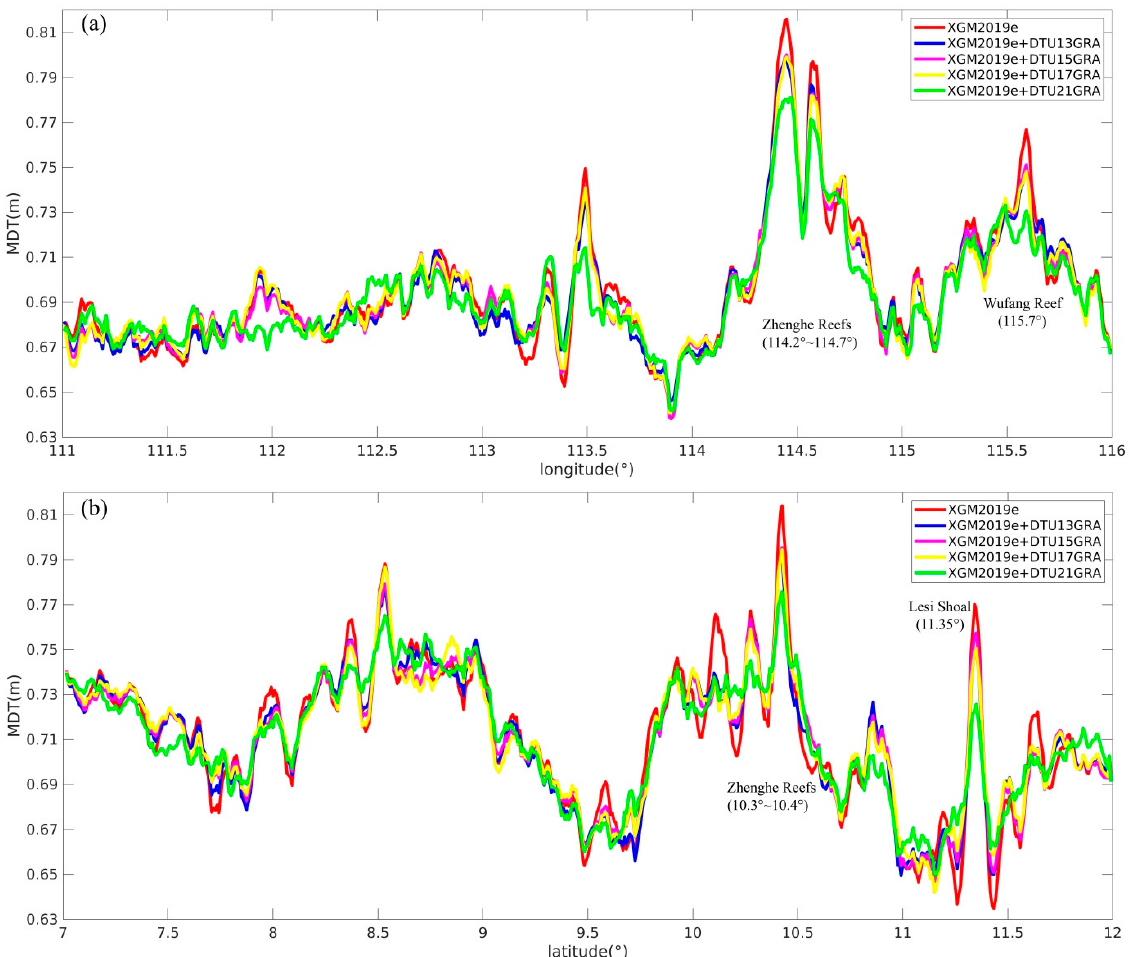
Figure 4. Profiles of various MDTs computed from different gravity field models along latitude 10.4°N ( a ) and longitude 114.6°E ( b ). Note: only DTU21GRA was computed with the SAR altimeter 10.4 ◦ N ( a ) and longitude 114.6 ◦ E ( b ). Note: only DTU21GRA was computed with the SAR altimeter data over the study area . data over the study